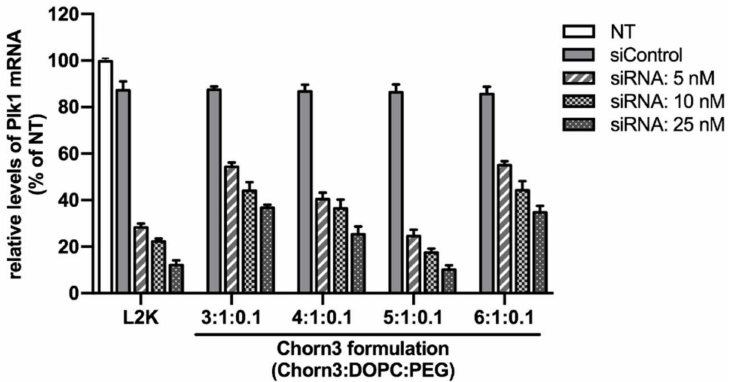
Figure 7. siRNA delivery e ffi ciency of Chorn3 formulations. Error bars illustrate s.d. of the